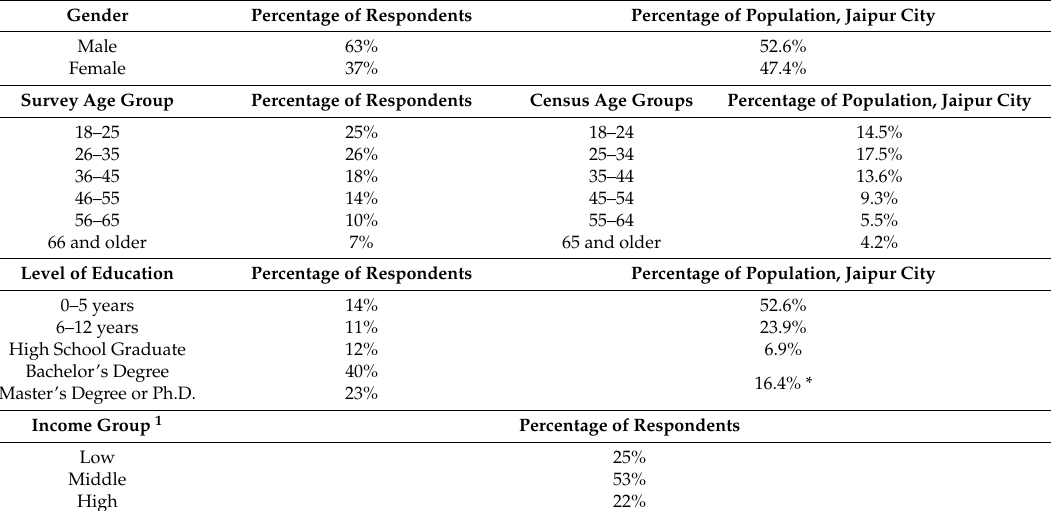
Table 1. Survey participant